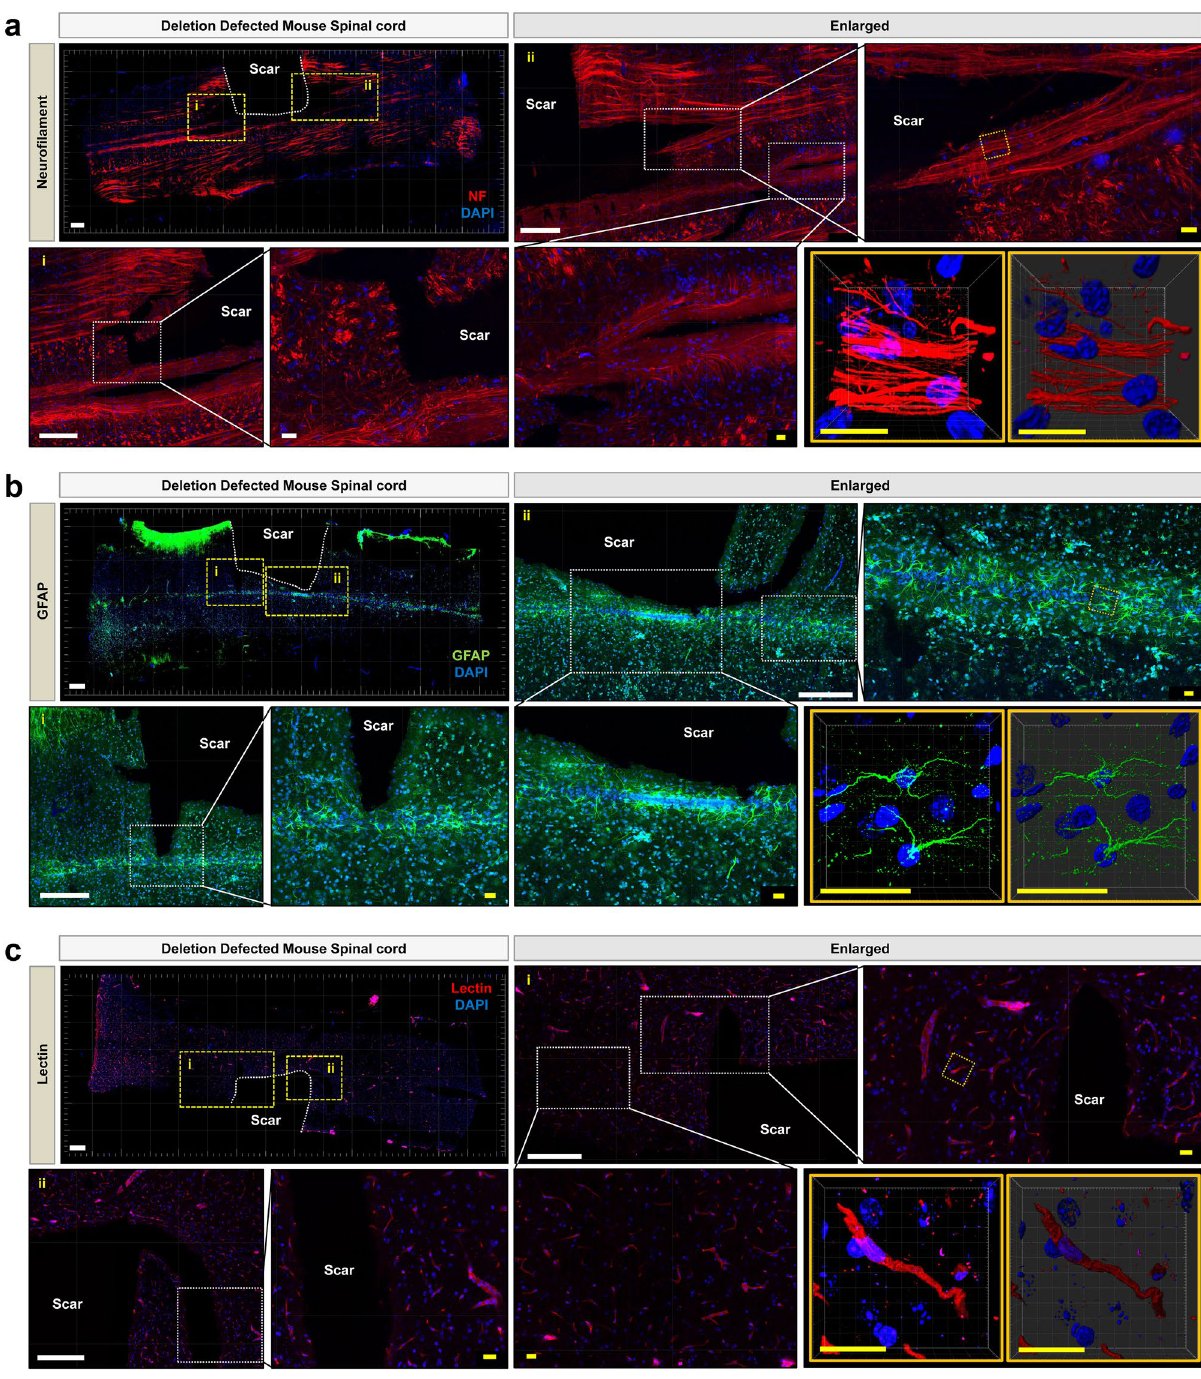
Figure 6. Paper-MAP processing of deletion spinal cord injury tissue in mouse. Representative tile-scanned images of samples from the deletion model of mouse spinal cord injury processed via Paper-MAP and immunostained for neurofilament (red) ( a ), GFAP (green) ( b ), and lectin (red) ( c ). Yellow and white boxes indicate enlarged and 3D-projection images (range: 100–150 μm). Dotted white lines indicate scar region. Scale bars: white = 1000-μm, yellow = 100-μm. Illustration of mechanism is visualized by PowerPoint (original MAP), we processed tissues harvested from mouse models of spinal cord injury according to our Tissue-MAP protocol, and performed immunostaining of lectin and DiD-D to visualize vasculature and neuronal networks, respectively. With the Tissue-MAP technique, we were able to successfully clear and expand injured spinal cord tissue such that we could observe blood vessel thinning and reduced neuronal density adjacent to the scar tissue, supporting its use for three-dimensional ultrastructural visualization of intact tissues. Nevertheless,